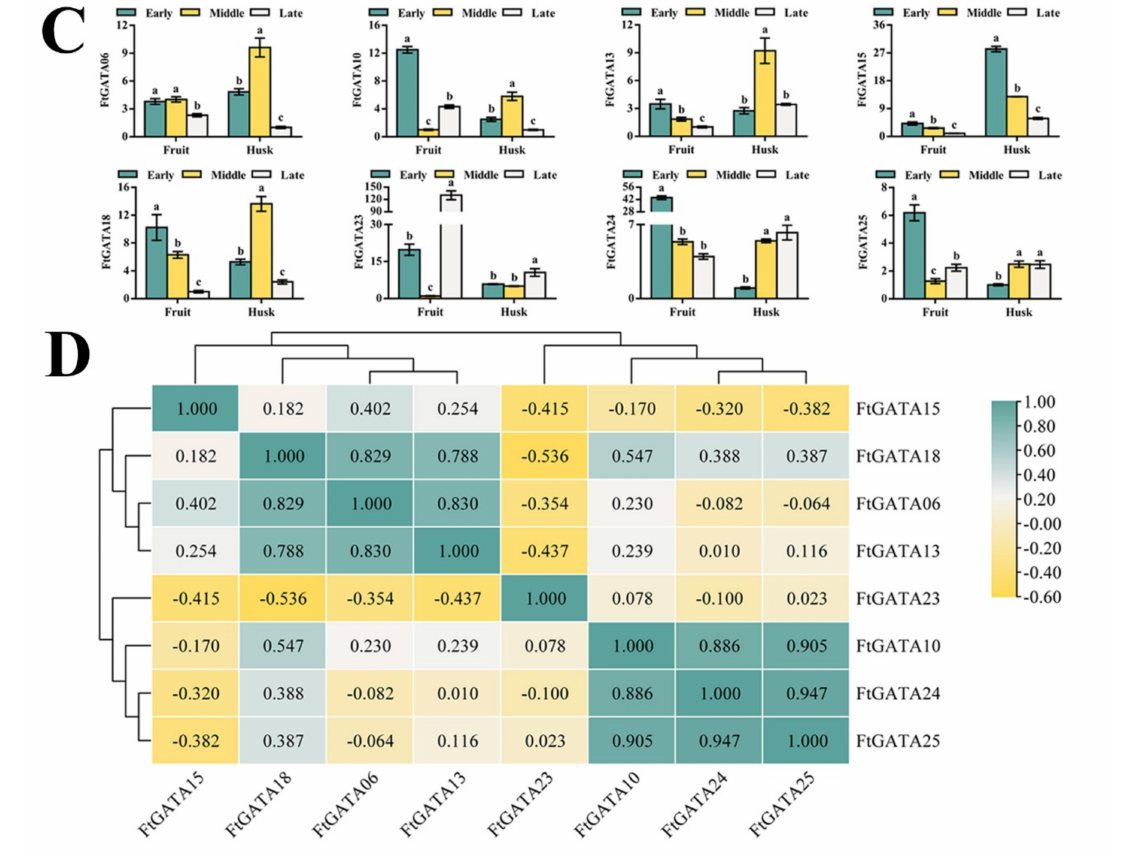
Figure 7. Relative expression levels and correlation hierarchical cluster analysis of 8 Fagopyrum tataricum GATA genes ( FtGATA06 , FtGATA10 , FtGATA13 , FtGATA15 , FtGATA18 , FtGATA23 , FtGATA24 , and FtGATA25 ) in tissues and during fruit development. ( A ) Expression patterns of eight FtGATA genes at the mid-grain filling stage in roots, stems, young leaves, mature leaves, flowers, fruit, and husks. ( B ) Correlation analysis between their expression in different tissues at the mid-grain filling stage. ( C ) Expression patterns of eight FtGATA genes in the fruit and husk during early, middle, and late grain-filling stages. ( D ) Correlation analysis between their expression in the fruit and husk during the grain-filling stage. Column chart values are expressed as the mean ± SD according to Duncan’s multiple comparisons; different lowercase letters represent significant differences among different treatments ( p < 0.05). Positive and negative numbers in the schematic graph of correlation represent positive and negative correlation, respectively; larger values indicate stronger